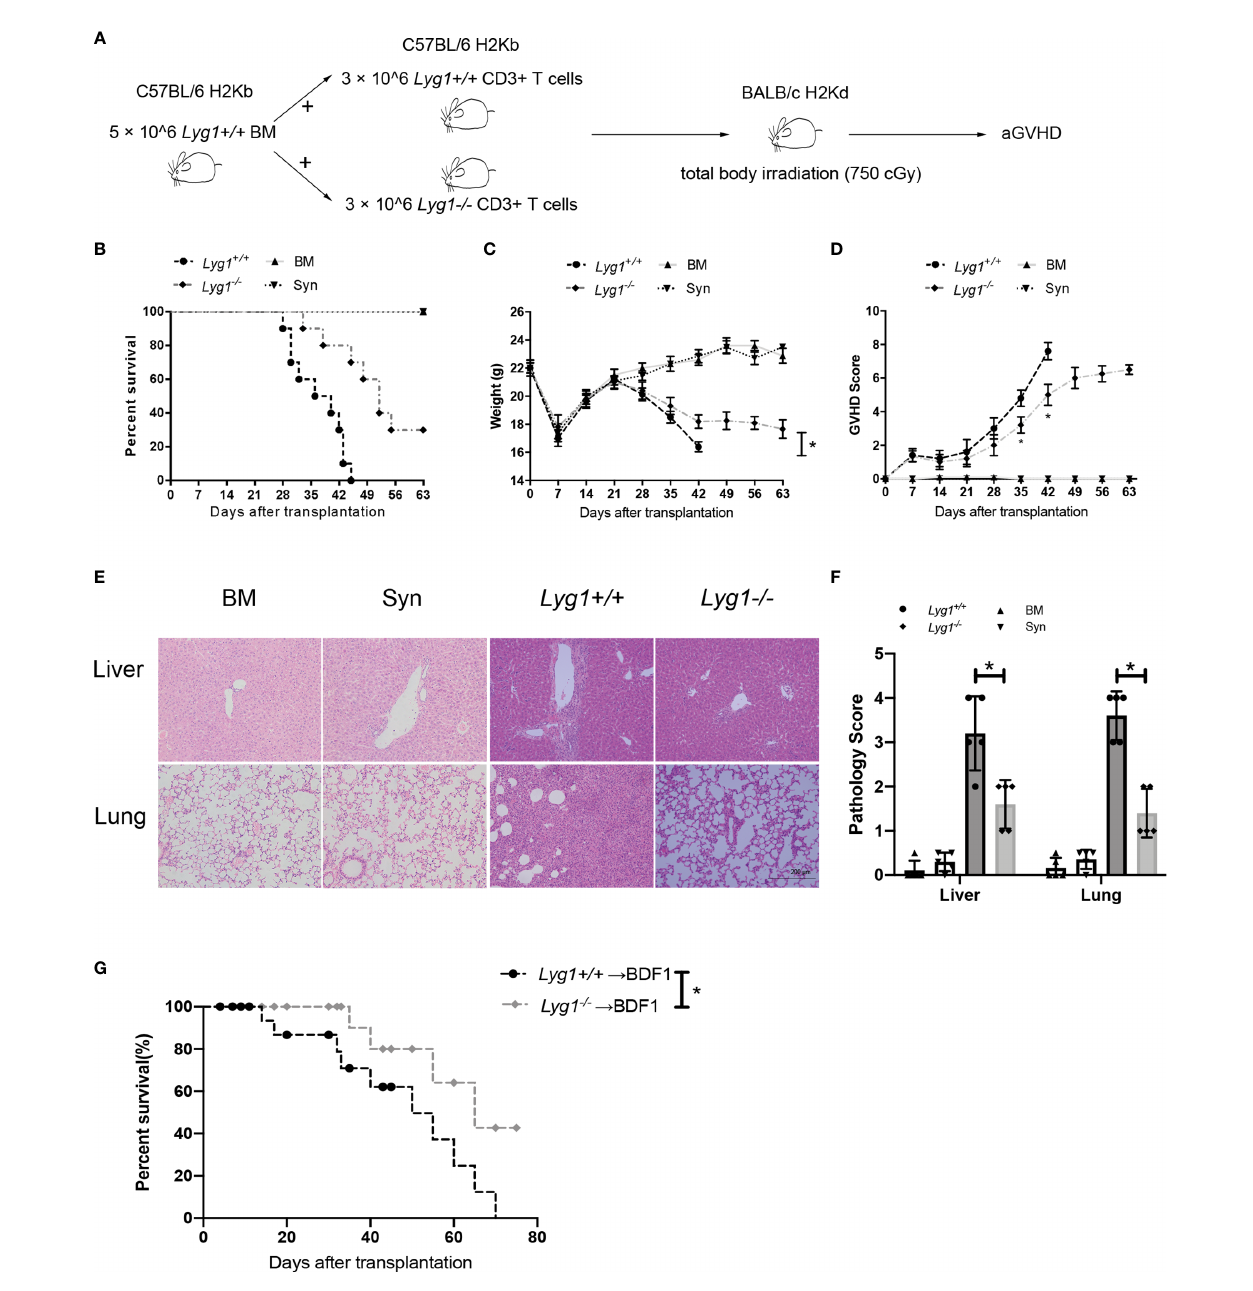
FIGURE 2 | LYG1 de fi ciency in donor T cells alleviated aGVHD. Lethally irradiated BALB/c mice were reconstituted with 5 × 10 6 Lyg1 +/+ BM and 3 × 10 6 T cells from Lyg1 +/+ mice ( Lyg1 +/+ group) or Lyg1 -/- mice ( Lyg1 -/- group). BM control (BM group) were given 5 × 10 6 Lyg1 +/+ BM alone. (A) The diagram illustrating the experimental procedure. Survival (B) , weight (C) and aGVHD scores (D) were monitored. (E) Histological examination (×200 magni fi cation) of liver and lung in four groups were analyzed on day 28 after transplantation. (F) Histologic scores of liver and lung were shown. (G) Survival of BDF1 recipients given transplants with 5 × 10 6 Lyg1 +/+ BM and 2 × 10 7 splenocytes from Lyg1 +/+ mice ( Lyg1 +/+ group) or Lyg1 -/- mice ( Lyg1 -/- group). Independent experiment was performed 3 times. Data pooled: 3 experiments (n = 10 for Lyg1 +/+ group and Lyg1 -/- group, n = 5 for BM group). Results are expressed as the mean ± SD, *p < 0.05 compared with Lyg1 +/+